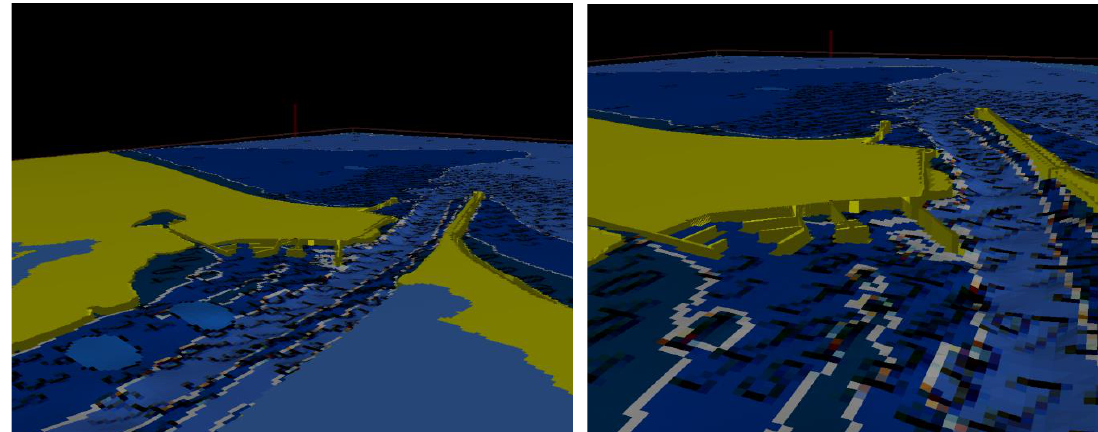
Figure 9. Spatial presentations of the NSC on the basis of the ENC PL5WISLA cell.